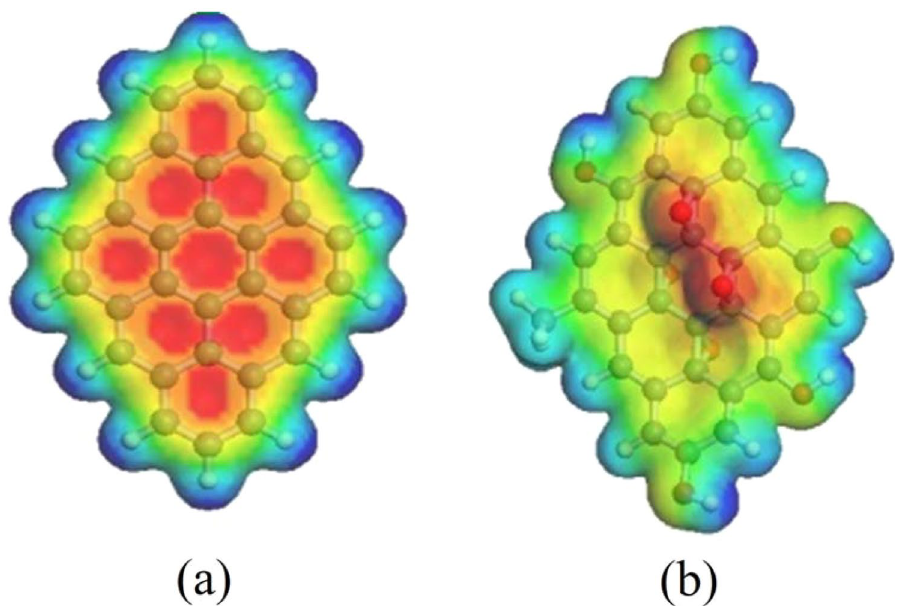
Figure 6. Molecular electrostatic potential (MESP) map of p1GQD (a) and fGQD (b). Electrostatics potentials are mapped on the surface of the electron density with the isosurface value of 0.1 unit. The red surface corresponds to a region of negative electrostatic potential, whereas the blue color corresponds to the positive